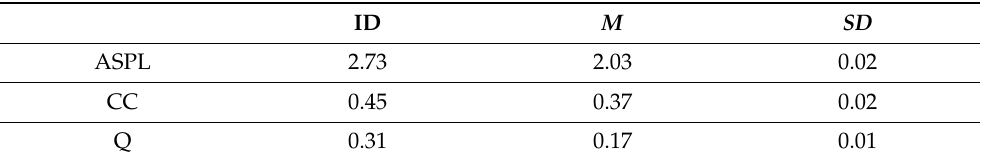
Table A2. Random Network comparison for the network of the adolescents with ID (dataset 1), p < 0.001 for all comparisons.